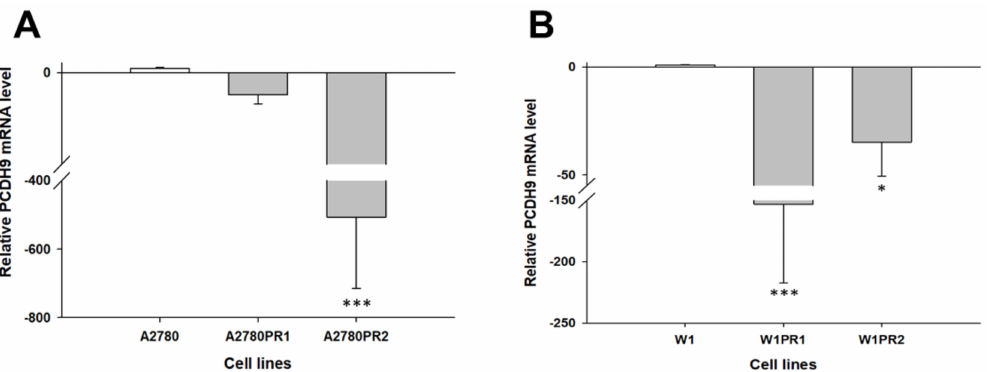
Figure 1. Expression analysis (Q-PCR) of the PCDH9 gene in the A2780 ( A ) and W1 ( B ) PAC-resistant cell sublines. The figure presents the relative gene expression in the resistant cell lines (grey bars) with respect to that in the sensitive cell line (white bars), which was assigned a value of 1. The values were considered significant at * p < 0.05 and *** p <